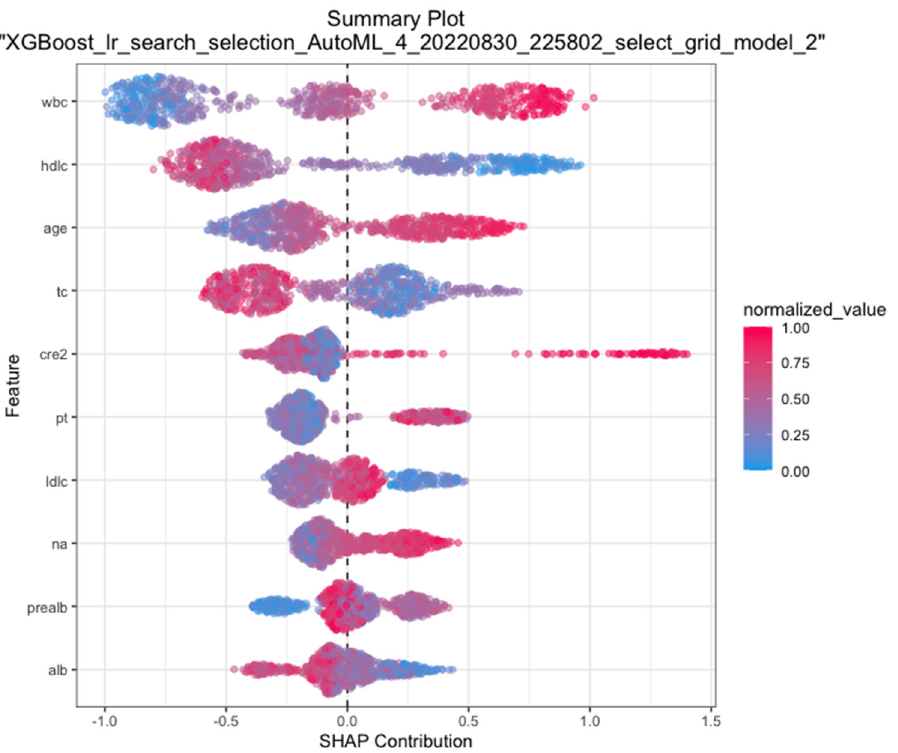
Figure 2. Relative importance of the variables in the XGBoost model. The chart shows that HDL-C was the most important variable, followed by Cre, WBC, INR, etc. Abbreviations: hdlc, high-density lipoprotein cholesterol; cre2, creatinine; wbc, white blood cell count; lninr, international normalized ratio; tc, total cholesterol; ldlc, low-density lipoprotein cholesterol; pt, prothrombin time; alb, albu- min; tbil2, total bilirubin.